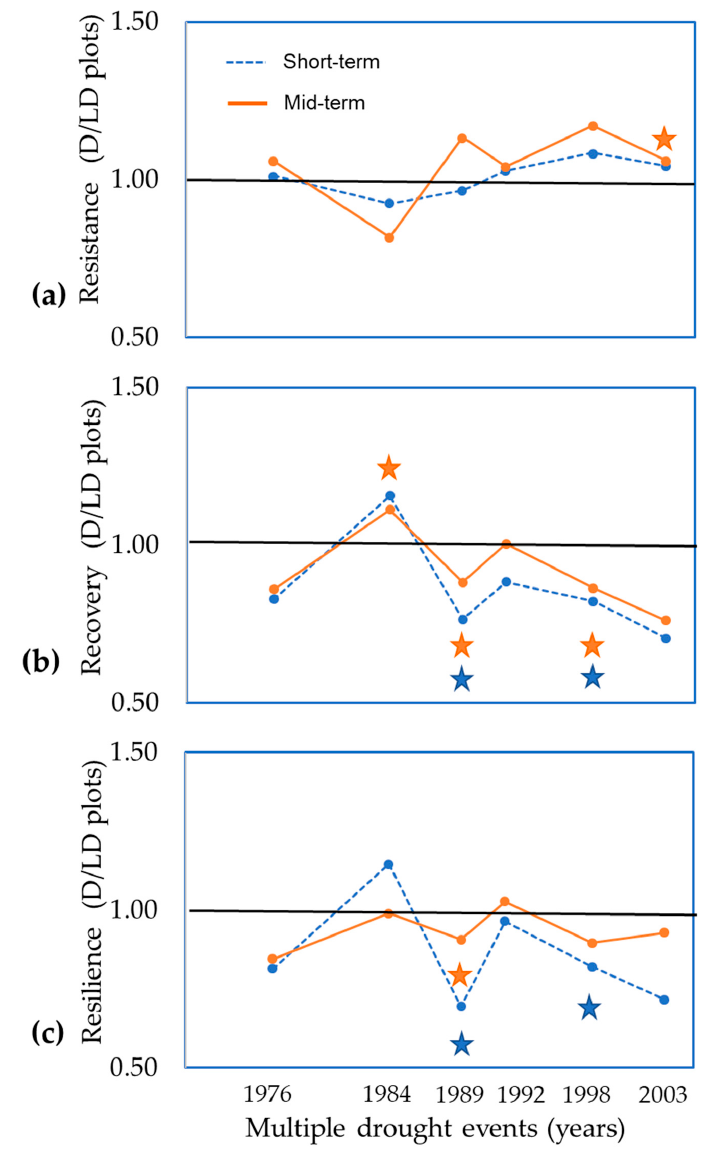
Figure 9. Comparison of short- and mid-term cumulative effect sizes for resistance ( a ), recovery ( b ), and resilience ( c ) between dry (D) and less-dry (LD) plots (three locations combined) by using response ratios for six multiple drought events. If the value is exactly 1, it means no difference between dry and less-dry plots. A bold straight line is added through the value 1 to highlight this. Values above 1 denote a higher response in dry plots, and values below 1 denote a lower response in dry plots than in less-dry plots. The difference between a response ratio value and 1 is the magnitude of difference (converted to %) in resistance, recovery, and resilience between dry and less-dry plots. Star marks indicate significant relationships among the six drought events. The orange and blue lines are only joining the values among the drought events.